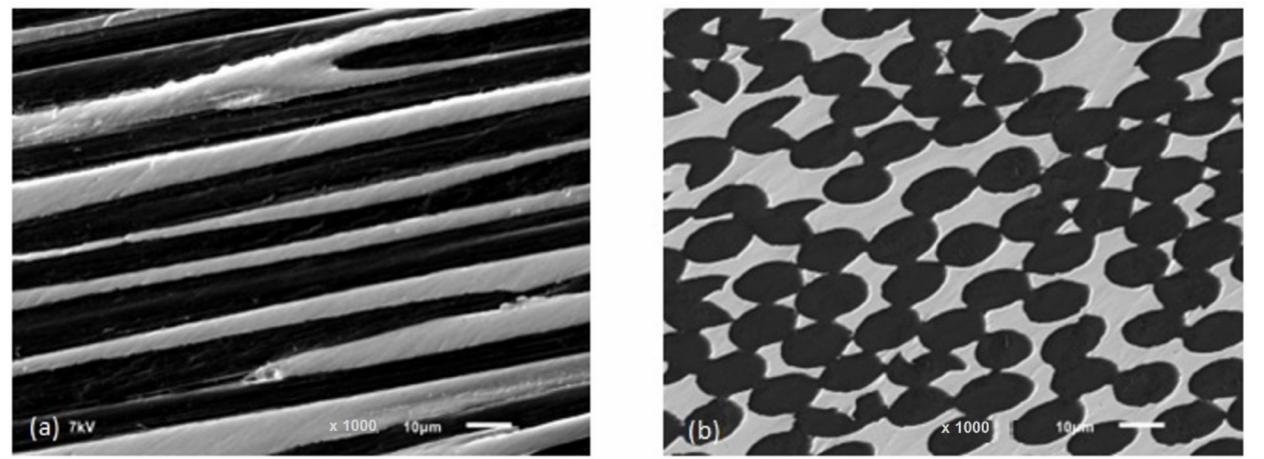
Figure 3. SEM microstructure of prepared Cf/Cu composites: ( a ) longitudinal to fibers; ( b ) perpen- dicular to fibers (IMMM